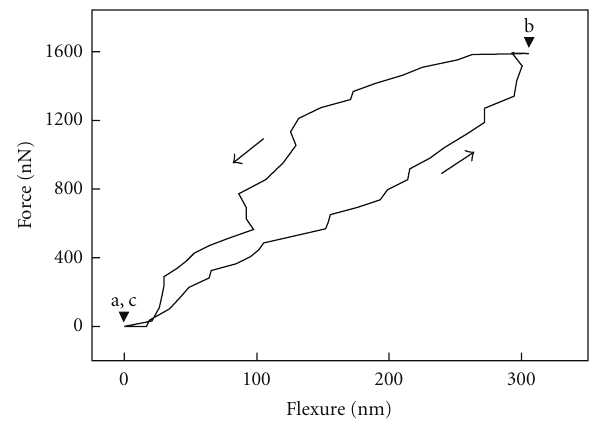
Figure 2: Force-flexure curve of C 70 nanowhisker during bending shown in Figure 1. Points a–c correspond to the states shown in Figures 1(a)–1(c), respectively. The arrows indicate the time path of